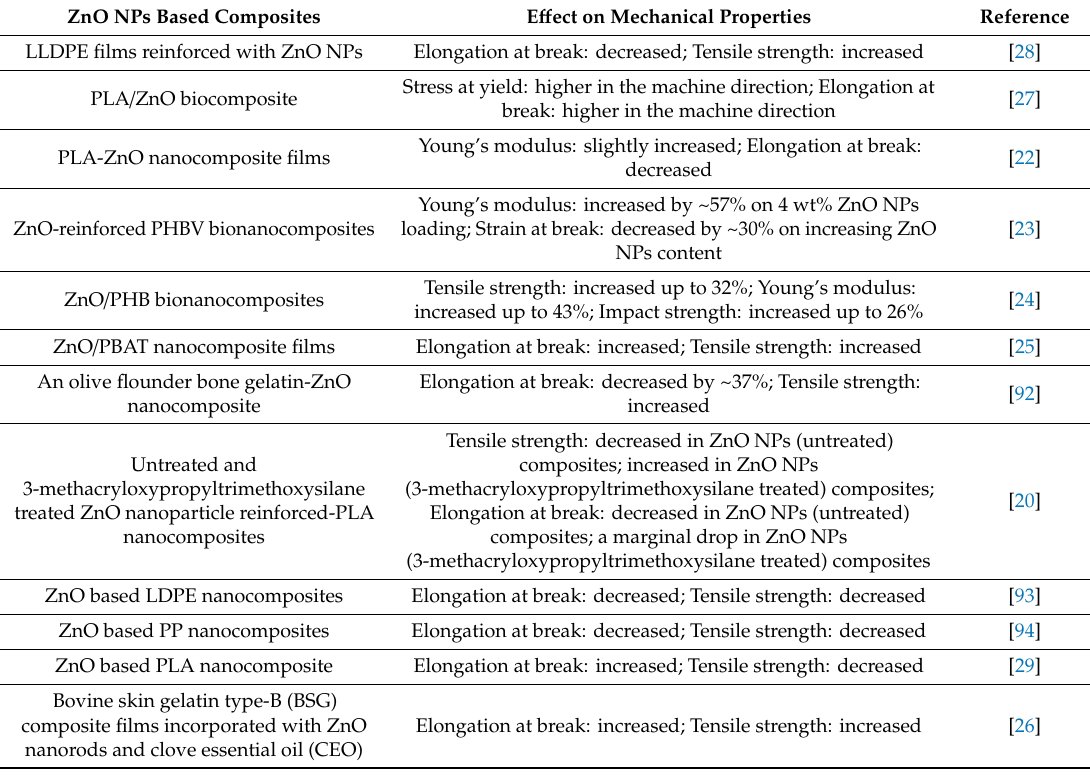
Table 5. Mechanical properties of ZnO NPs based (bio)polymer